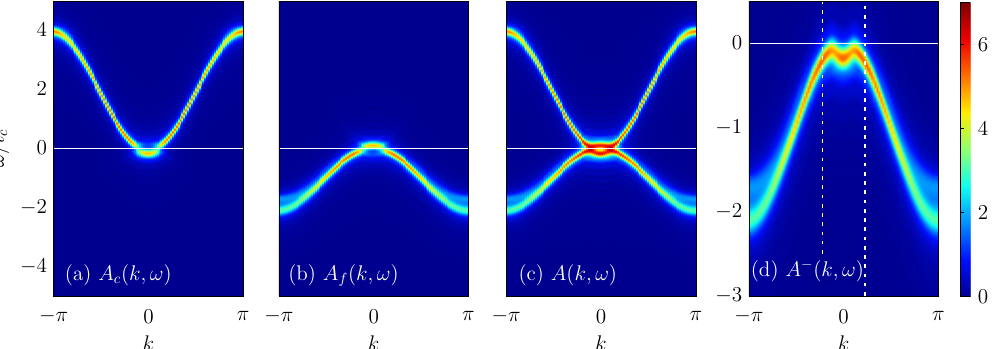
Figure 2: Zero-temperature single-particle spectral functions A α ( k , ω ) , A ( k , ω ) and / t = − 0.5, D / t = 2.11, and U / t = 1. A − ( k , ω ) in the 1D half-filled EFKM with t f c c c 〉 = 0.1. The dashed lines in panel (d) The mean c -electron density is fixed to be 〈 ˆ n c j [ 11 ] . mark the momentum interval considered in ARPES experiments on Ta NiSe 2 5 = 200 to keep the Results are obtained by t-DMRG using IBC and a window size L W values of the dynamical correlation functions on the boundaries less than 10 − 8 up to · t = 16. We note that the unit cell for the iDMRG simulations the target time t c fin = 10) to realize the small c -electron density 〈 ˆ n c 〉 = needs to be large ( N uc j